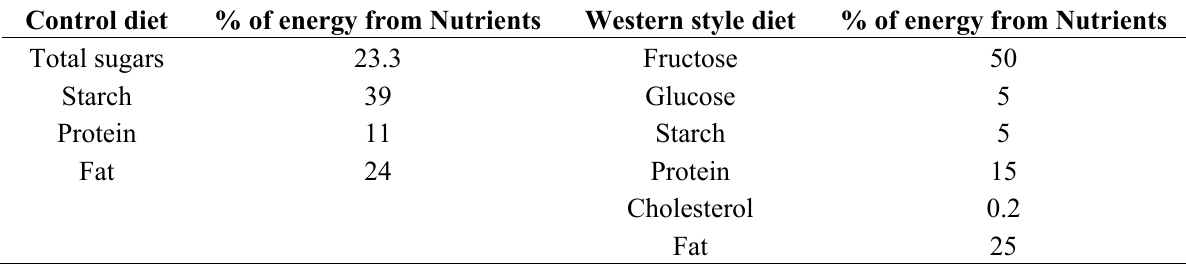
Table 2. Composition of a liquid based control and Western style